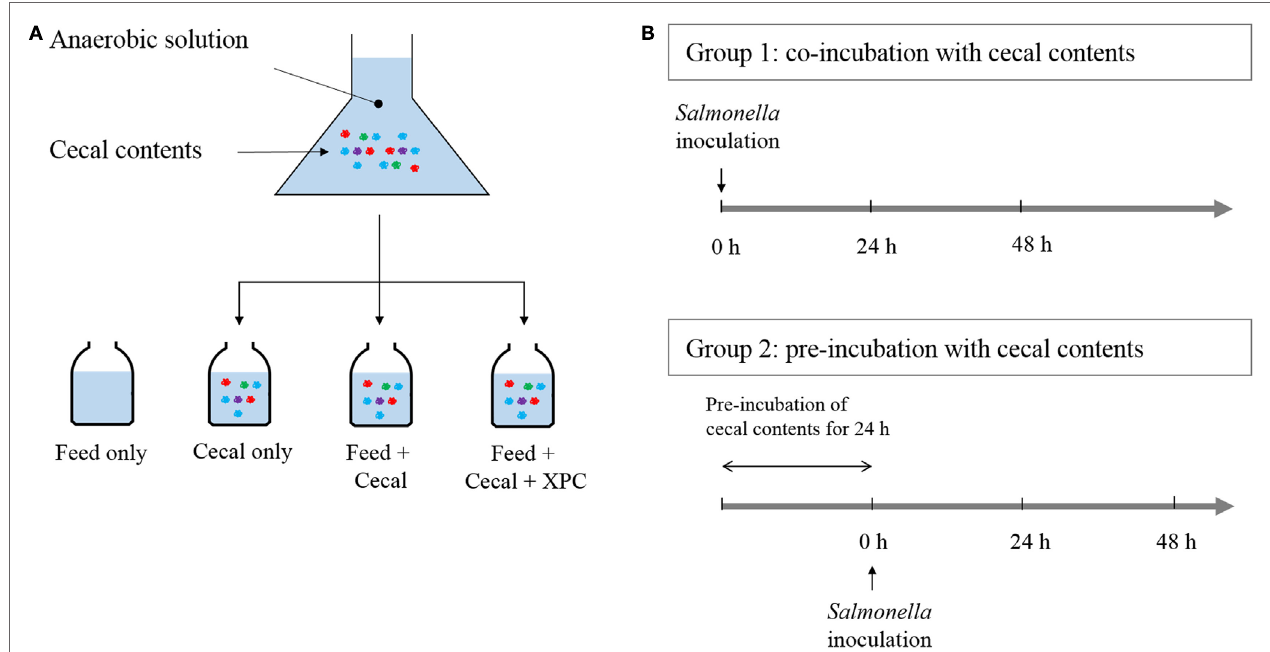
FigUre 1 | anaerobic experimental strategy . (a) Cecal content is added to anaerobic solution with chicken feed and fermentation metabolites of Original XPC. Controls contain (1) chicken feed, but no cecal content; (2) cecal content, but no chicken feed and; (3) feed + cecal content, respectively. Experimental treatments contain feed, cecal contents, and XPC. (B) Group 1 cultures receive Salmonella at the same time as cecal content (at 0 time). Group 2 cultures receive Salmonella after a 24 h incubation of cecal content under anaerobic conditions. Each culture is then incubated with Salmonella for 48 h.